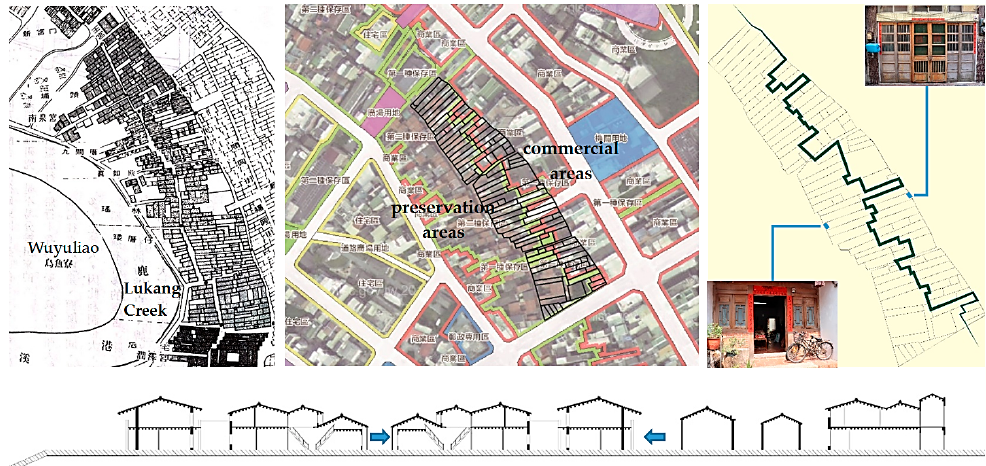
Figure 3. Site plan of the old harbor [57], zoning map, and differentiated street block ( top , from left to right ); cross section of four streets ( bottom ).